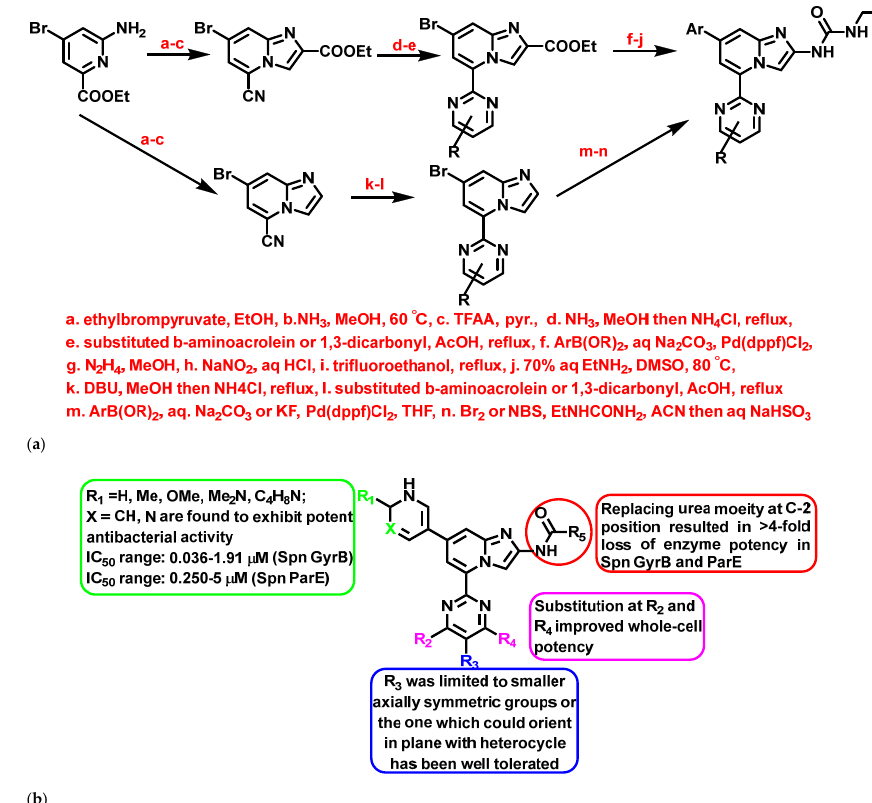
Figure 13. ( a ) General synthetic scheme of 5-(2-Pyrimidinyl)-imidazo [1,2-a]pyridine derivatives. Signatures of compounds according to Starr et al., 2009 [67]. ( b ) A brief SAR on imidazopyridine derivatives exemplifying the enzyme inhibitory activity. Signatures of compounds according to Starr et al., 2009 [67].